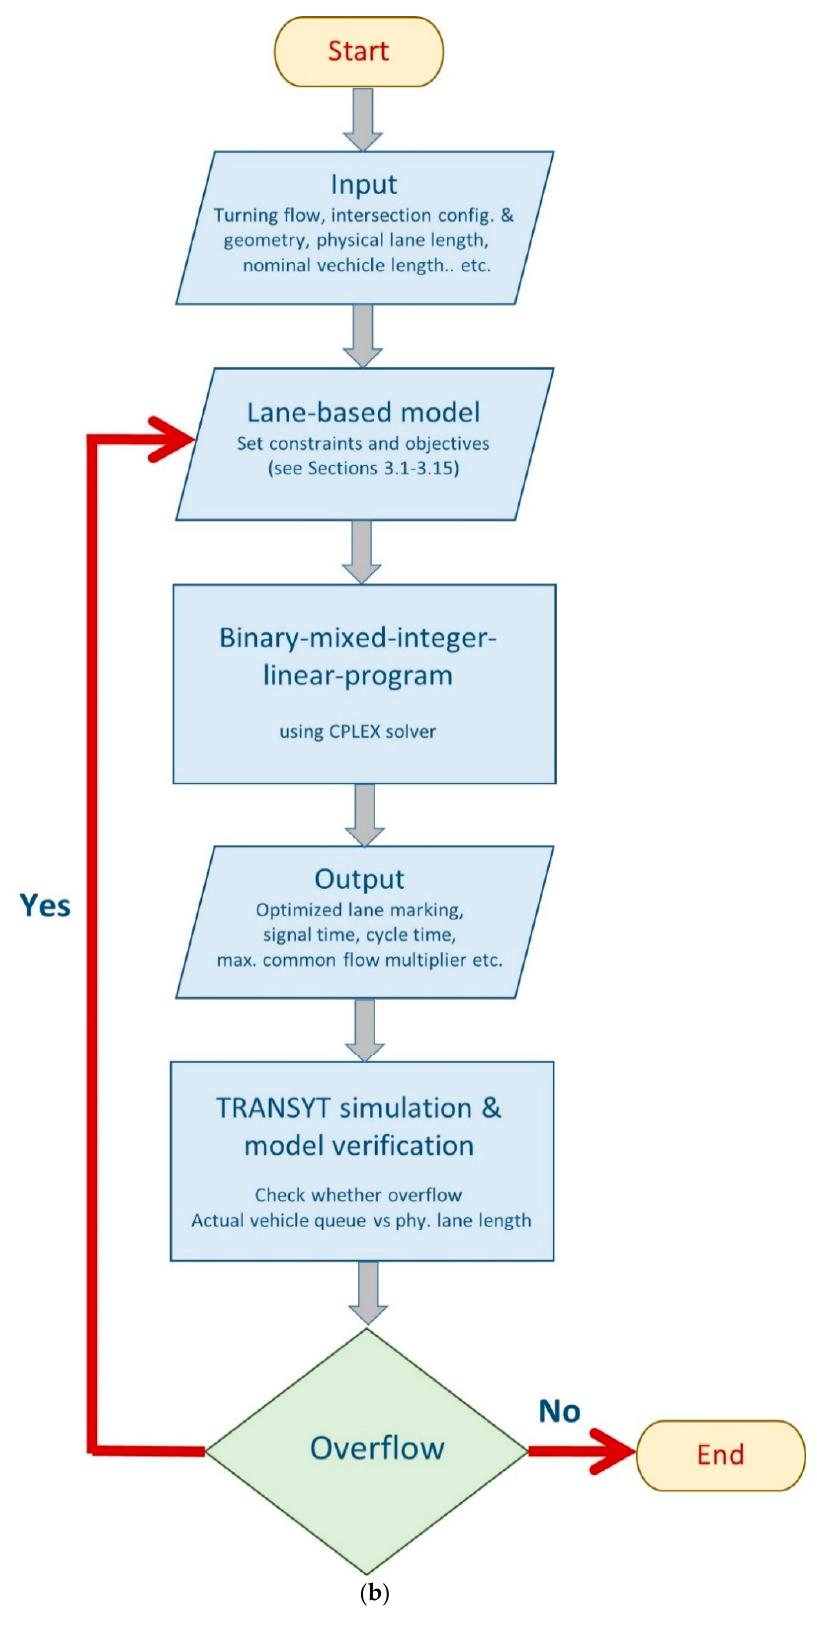
Figure 3. Descriptions of the traffic signal system and the methodology. ( a ) General queue development pattern on approach lane k from arm i under traffic signal control. ( b ) Flowchart of solving the lane-based problem.